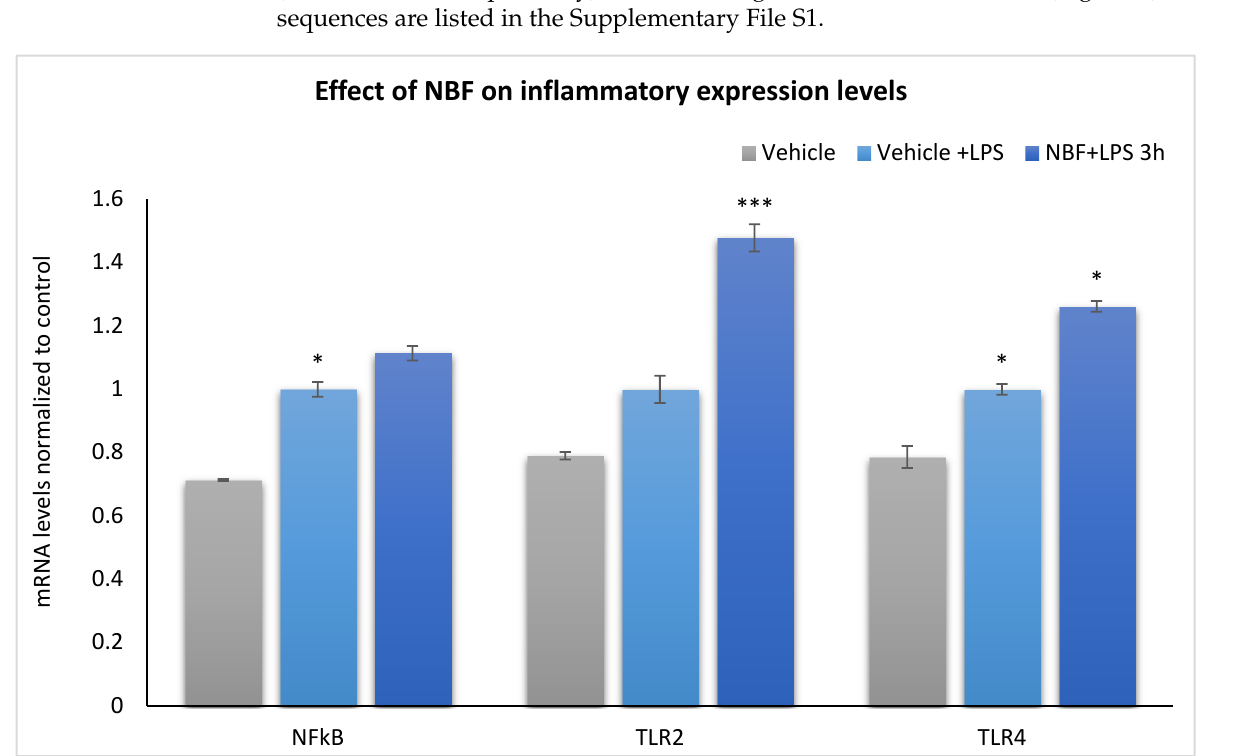
Figure 5. NBF downregulates the secretion of nitrite in RAW264.7 macrophages following LPS stimulation. RAW 264.7 macrophages were exposed to 20 ng/mL LPS and simultaneously with the NBF, 20 µg/mL. Nitrite levels were measured using standard calibration curve with sodium nitrite and are presented as the mean ± SD. Four replicates in each group ( n = 4). ANOVA followed by Bonferroni’s post hoc test was performed. *** p < 0.001 compared to all other groups.